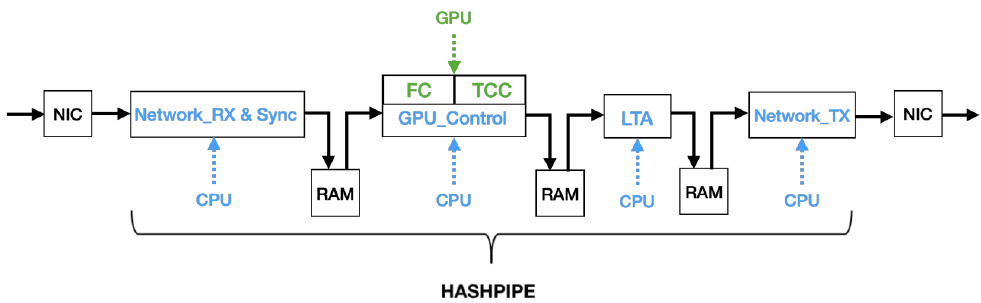
Figure 4. Diagram of the proposed X-engine